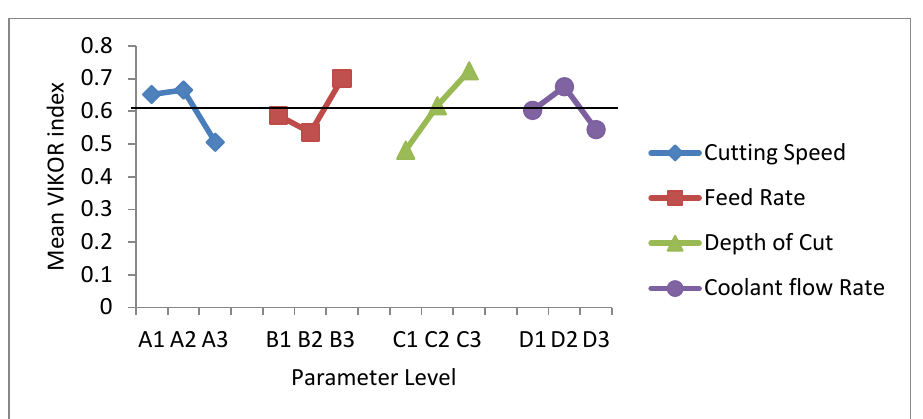
Fig. 5. Response graph of grey relational grade (GRG)